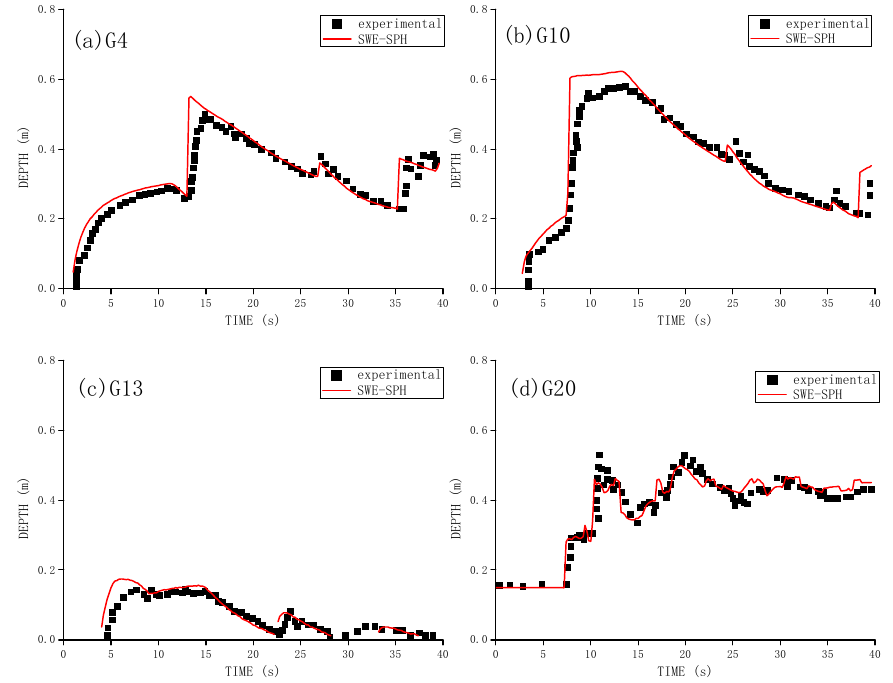
Figure 2. Time histories of dam break flow surface profile at gauging points between experimental data [19] and SWE-SPHysics modeling results at: ( a ) G4; ( b ) G10; ( c ) G13 and ( d ) G20.